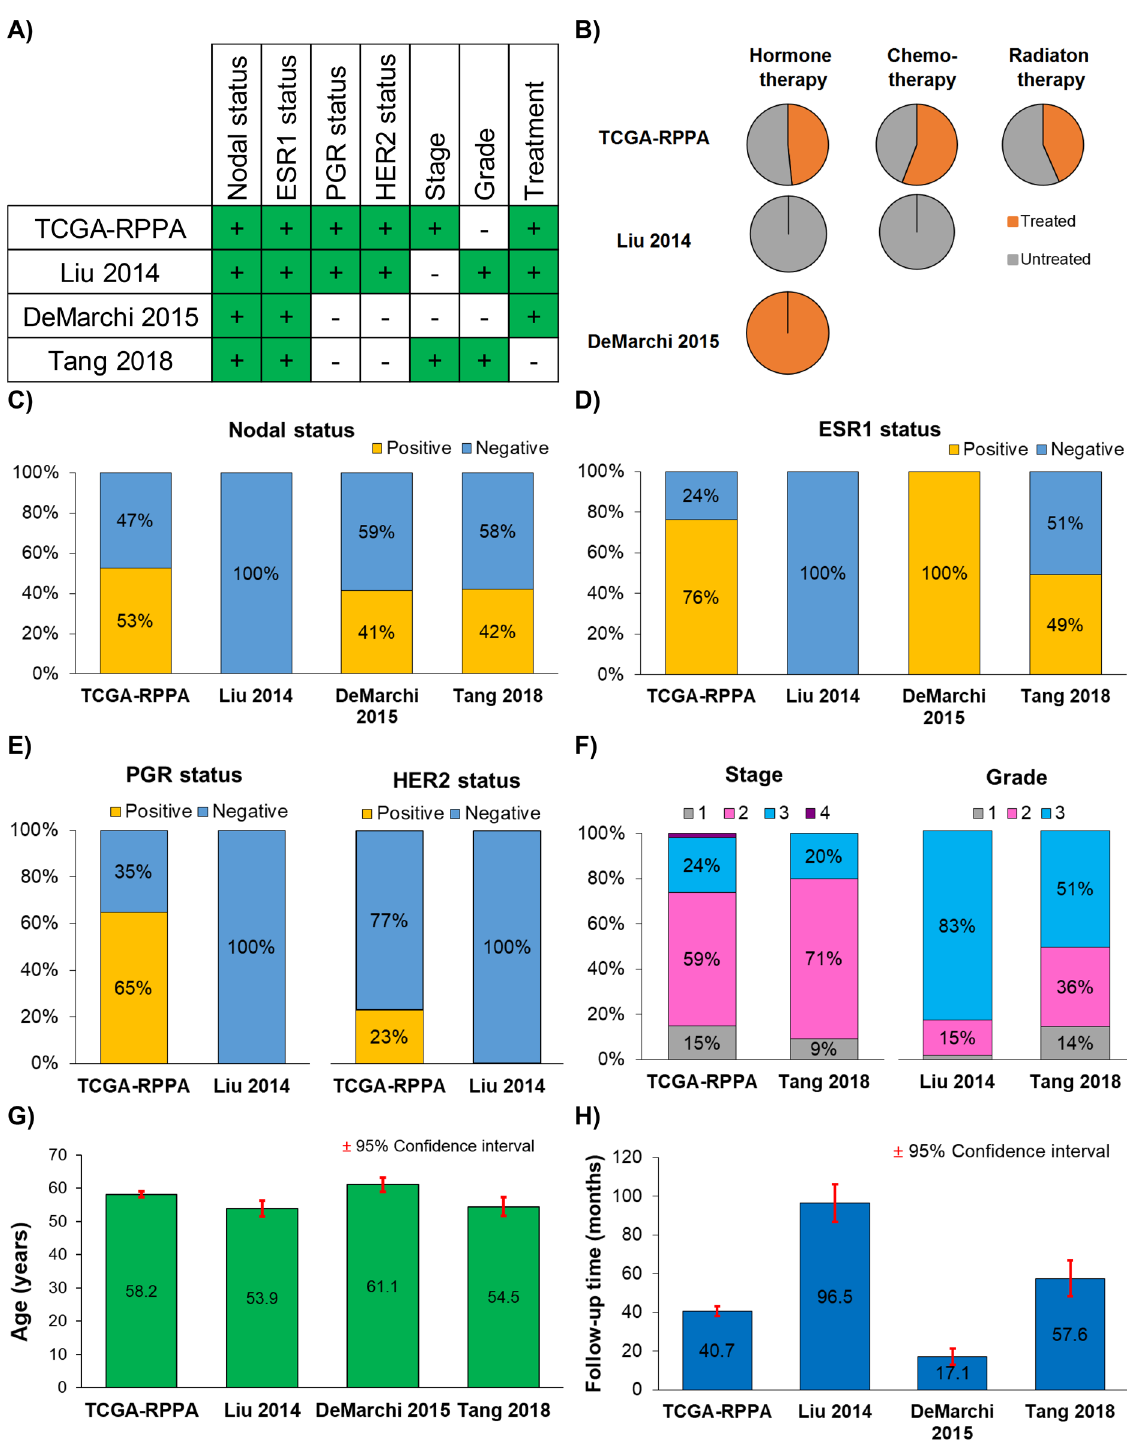
Figure 2. Clinical characteristics of the breast cancer patients used in this study. ( A ) Availability of clinical data in the included cohorts; ( B ) the proportion of patients treated with radiation, hormones or chemotherapy. ( C ) Percentage of patients by nodal status in each dataset; ( D ) , ( E ) the proportion of patients by receptor status for ESR1, PGR and HER2 in each dataset; ( F ) the distribution of stage and grade; ( G ) the mean age of patients; and ( H ) the mean follow-up time in each